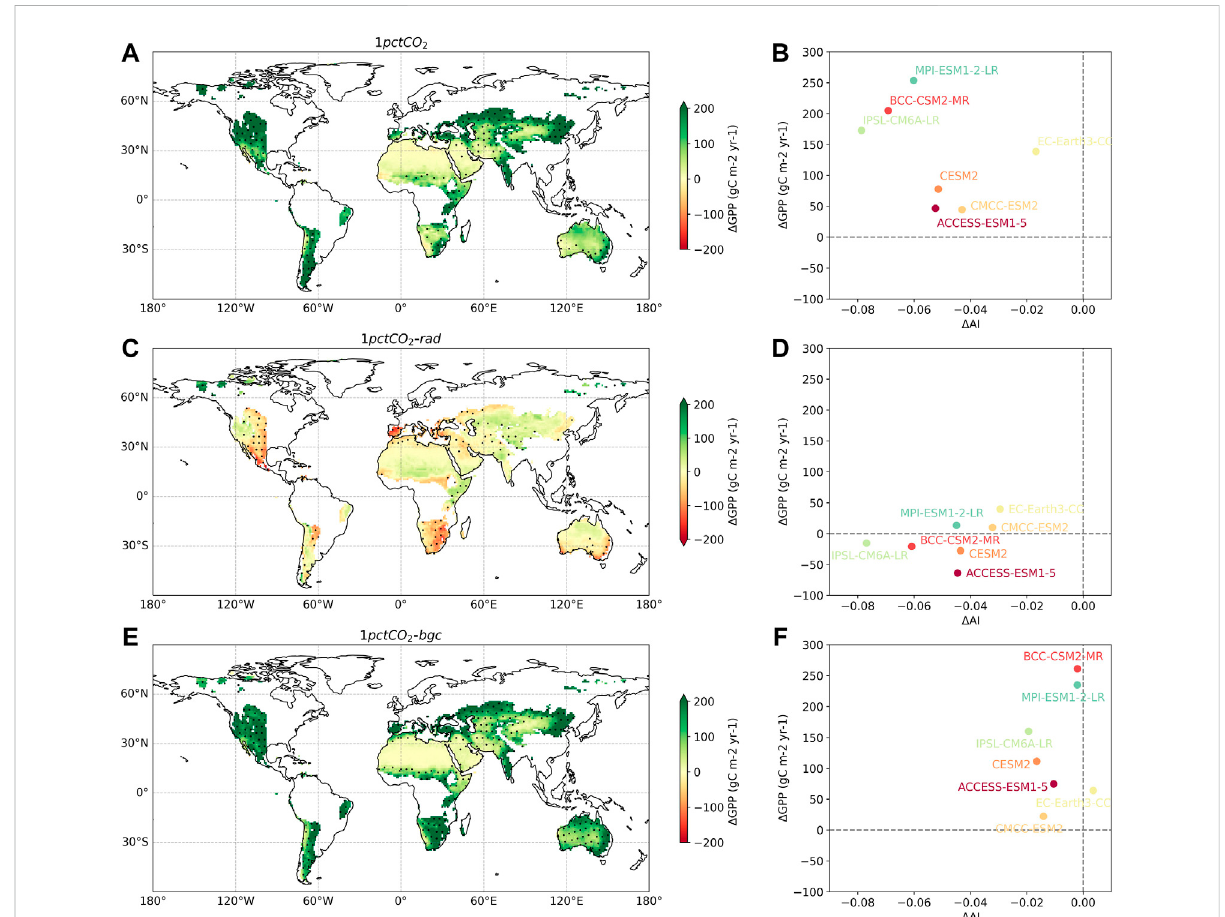
FIGURE 5 GPP and AI changes produced by the fully (A,B) , biogeochemically (C,D) , and radiatively (E,F) coupled simulations of CMIP6 ESMs. (A,C,E) The spatial distribution ofGPP changes from the threesimulations, calculated as thedifference between theaverage GPP in thelast 20 yearsof the140- yearsimulationperiodandthatinthe fi rst20 years.Theblackdotsin (A,C,E) denoteregionswheremorethan80%ofESMshavethesamesignasthe multi-model mean. (B,D,F) Scatterplot of GPP changes against AI changes aggregated over all global drylands, across the seven ESMs. Both AI and GPP changes are calculated as the difference between the last 20 years and the fi rst 20